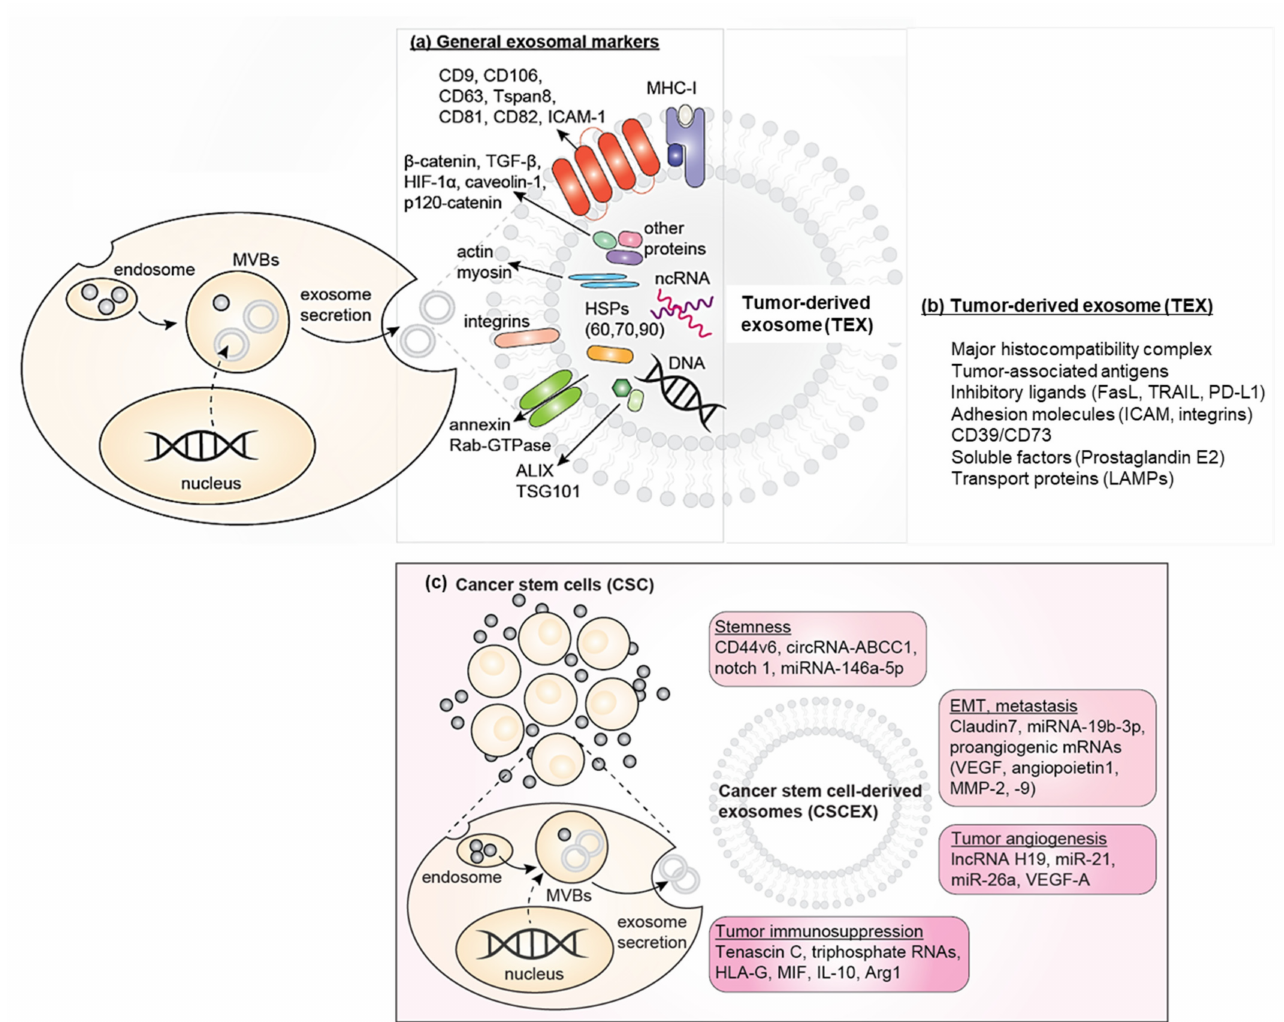
Figure 1. Schematic diagram of cancer stem cell-derived exosomes (CSCEXs) and their cargo. ( a ) General exosomal markers. ( b ) The content unique to tumor-derived exosomes [55]. ( c ) CSCEXs promote cancer stemness, epithelial– mesenchymal transition (EMT)/metastasis, and tumor angiogenesis, and contribute to immunosuppression in the tumor microenvironment [52]. CSCEXs mediate multiple actions through the delivery of microRNA (miR), long non-coding RNA (lncRNA), circular RNA (circRNA), proteins, cytokines, or transcription